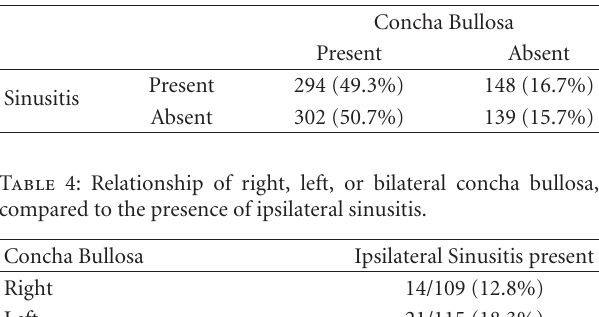
Figure 8: Coronal CT scan demonstrating right nasal septal deviation and severe bilateral maxillary sinusitis. No concha bullosa is present. The left maxillary sinus has a greater degree of inflammatory involvement than the right sinus. Table 3: Relationship of concha bullosa and sinusitis.